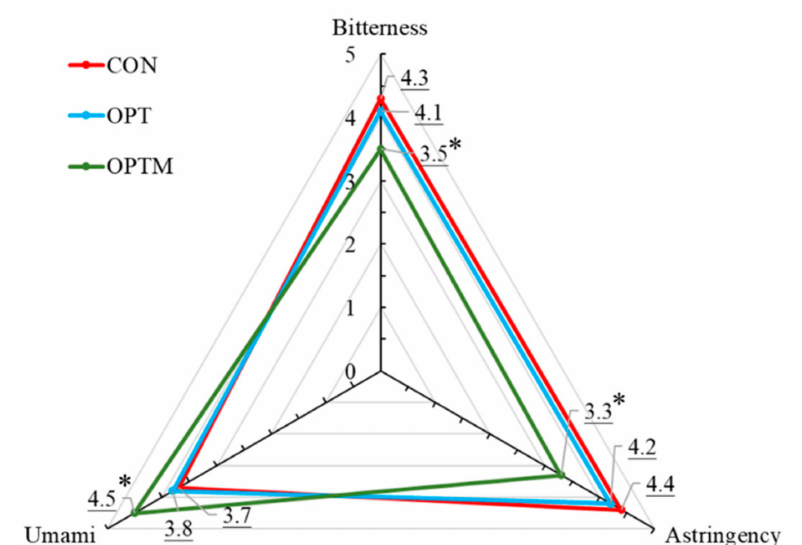
Figure 2. Spider web plot of the sensory indicators of oolong tea. Underlined numbers represented individual taste scores of conventional fertilization (CON, red), optimized fertilization (OPT, blue), and optimized fertilization supplemented with Mg (OPTM, green) teas determined by the panelists. “*” indicated significance at p < 0.05 by one-way ANOVA